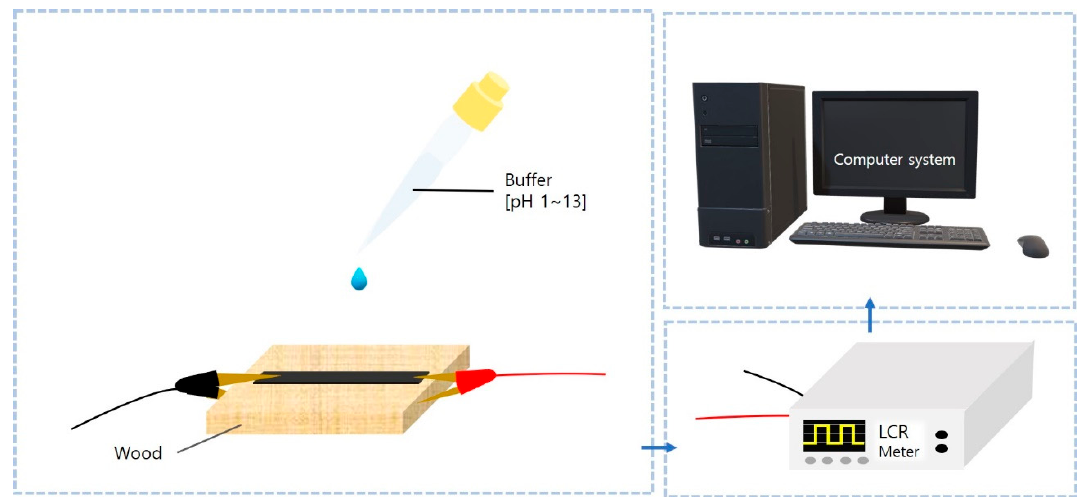
Figure 4. Schematic diagram of pH buffer being carefully dropped onto natural polymer-based sensor.